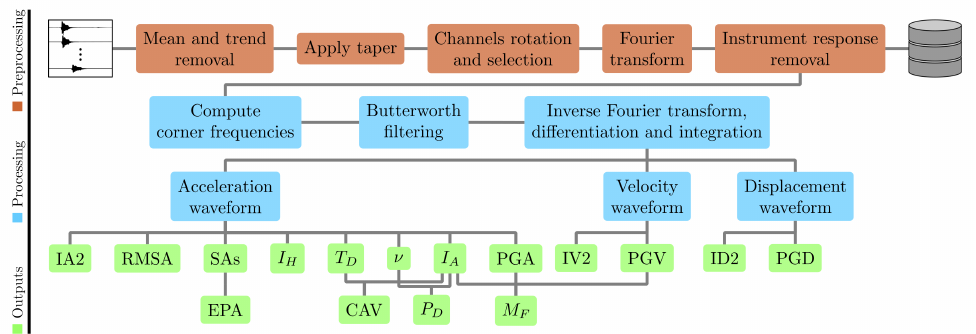
Figure 5. Flowchart of the automatic near-real-time strong motion data analysis implemented at CAED to calculate the source parameters, such as M 0 and stress drop, and engineering and damage parameters such as PGA, PGV, PGD, I H and I A , and